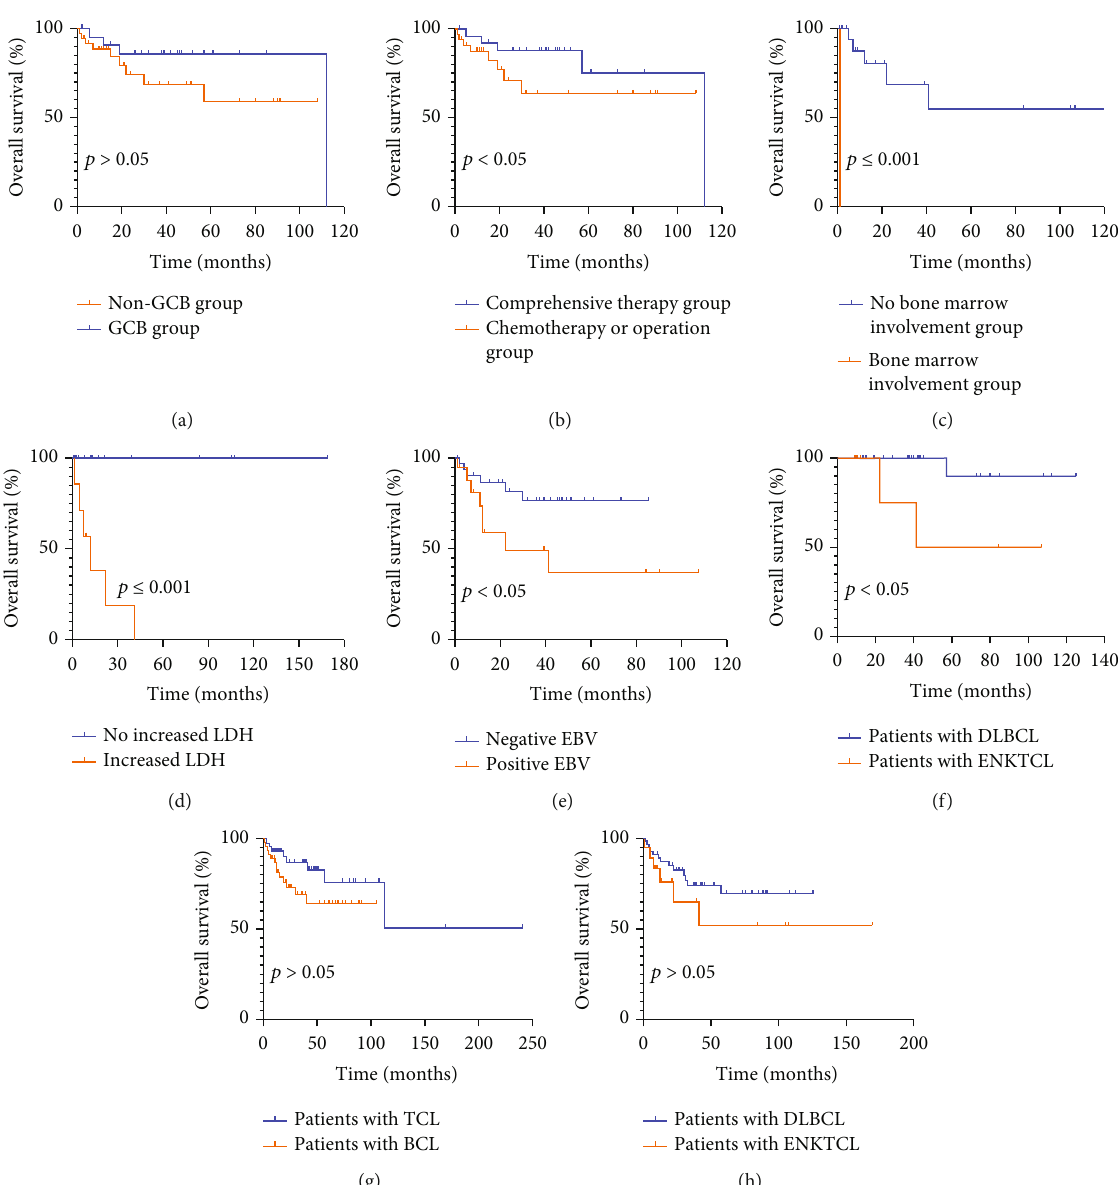
Figure 6: Univariate analysis of patients with primary extranodal non-Hodgkin ’ s lymphoma in the head and neck region among various groups. (a) The prognosis of patients with GCB type was better than that of patients with non-GCB subtype. (b) Comprehensive treatment and operation or chemotherapy was related to the OS of DLBCL patients. (c, d) For patients with ENKTCL, bone marrow involvement and increased LDH were related to OS. (e) The OS of patients with positive EBV was lower than that of the negative patients. (f) When comprehensive treatment was applied, the OS of patients with DLBCL was higher than that of patients with ENKTCL. (g) There was no di ff erence in OS between patients with T-cell lymphoma and B-cell lymphoma. (h) There was no di ff erence in OS between patients with DLBCL and ENKTCL. LDH: lactate dehydrogenase; ENKTCL: extranodal NK/T-cell lymphoma, nasal type; DLBCL: di ff use large B-cell